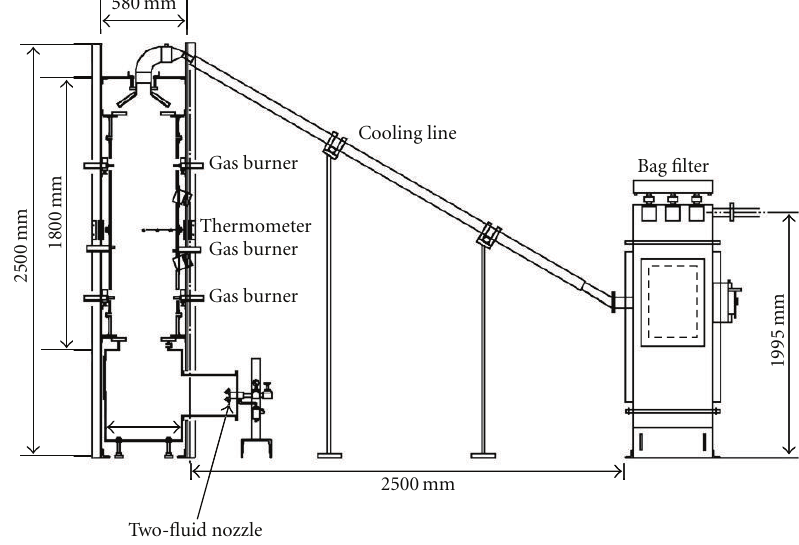
Figure 1: Schematic diagram of flame spray pyrolysis